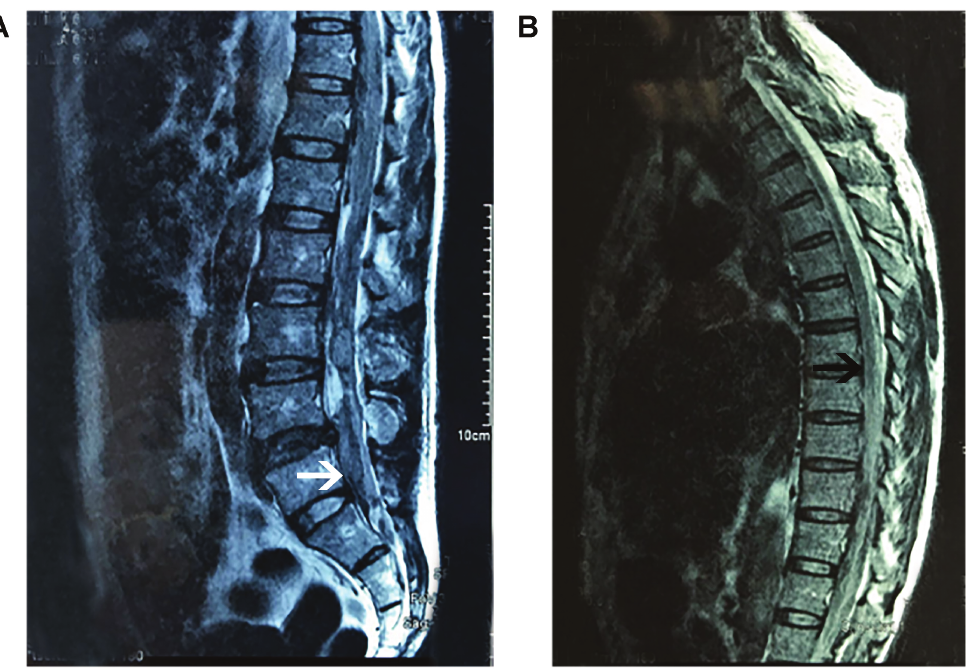
Figure 1: MRI T2WI indicated spinal subdural hematoma from S1 (A, white arrow) extending to T7 (B, black